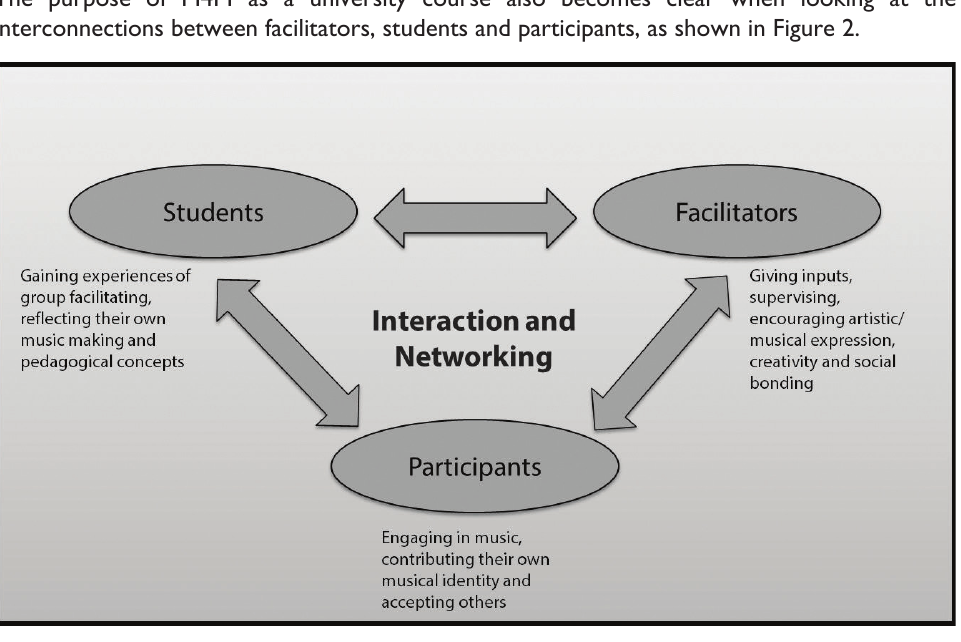
Figure 2: Interaction and networking between facilitators, participants and